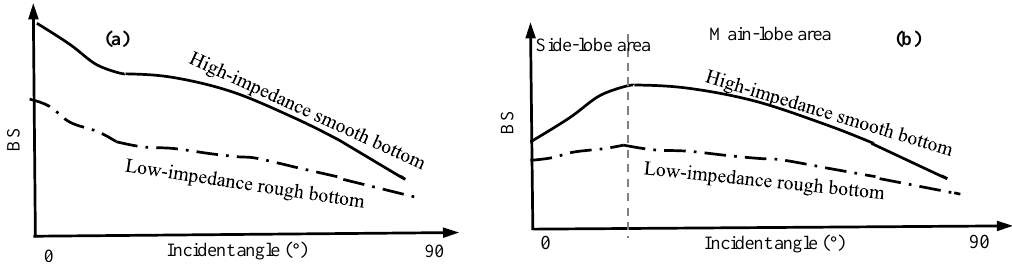
Figure 3. ( a ) angular response (AR) effect on side scan sonar (SSS) backscatter with different sediments; and ( b ) combined effects of the beam pattern and angular response on SSS backscatter.